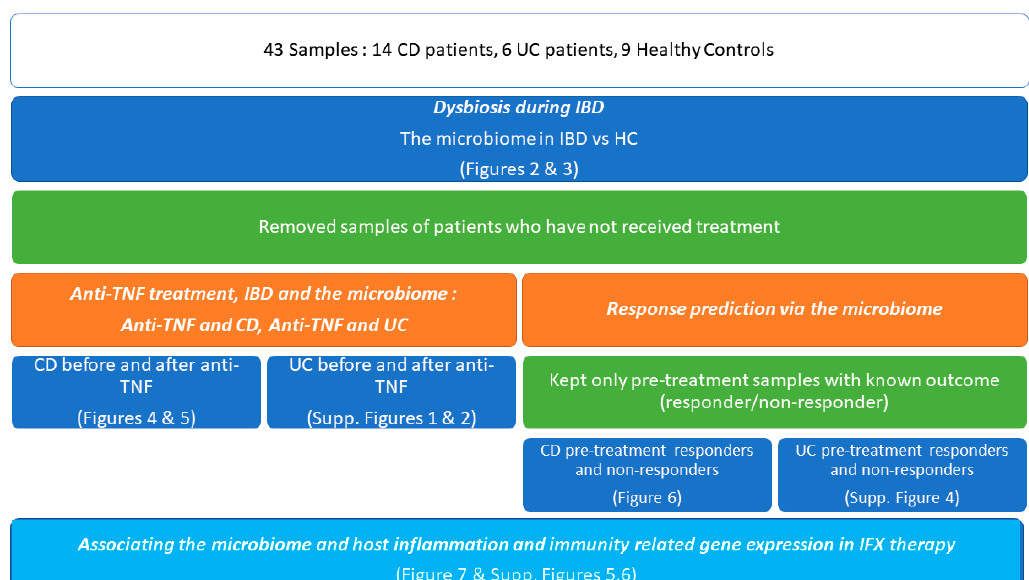
Figure 1. Overall design of the study. This protocol allowed us to showcase IBD vs healthy controls dysbiosis, to highlight the influence of Infliximab on microbiota composition and identify response-related microbial and transcriptional biomarkers.